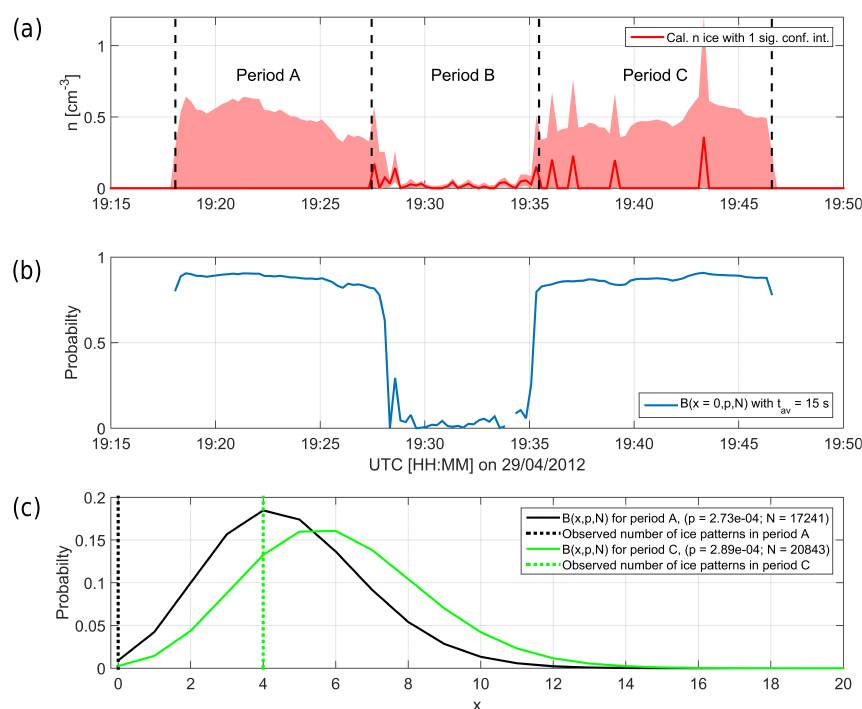
Figure 18. (a) : deduced ice number concentrations during VERDI flight 7 already shown in Fig. 17d. (b) : assuming the mean ice concen- tration of period B to be present in periods A and C; the probability to find no ice B(x = 0 ,p,N) with t av = 15s for the course of the measurement. (c) : assuming the mean ice concentration of period B to be present in periods A and C; binomial probability distributions for the occurrence of ice patterns for the entire periods A and